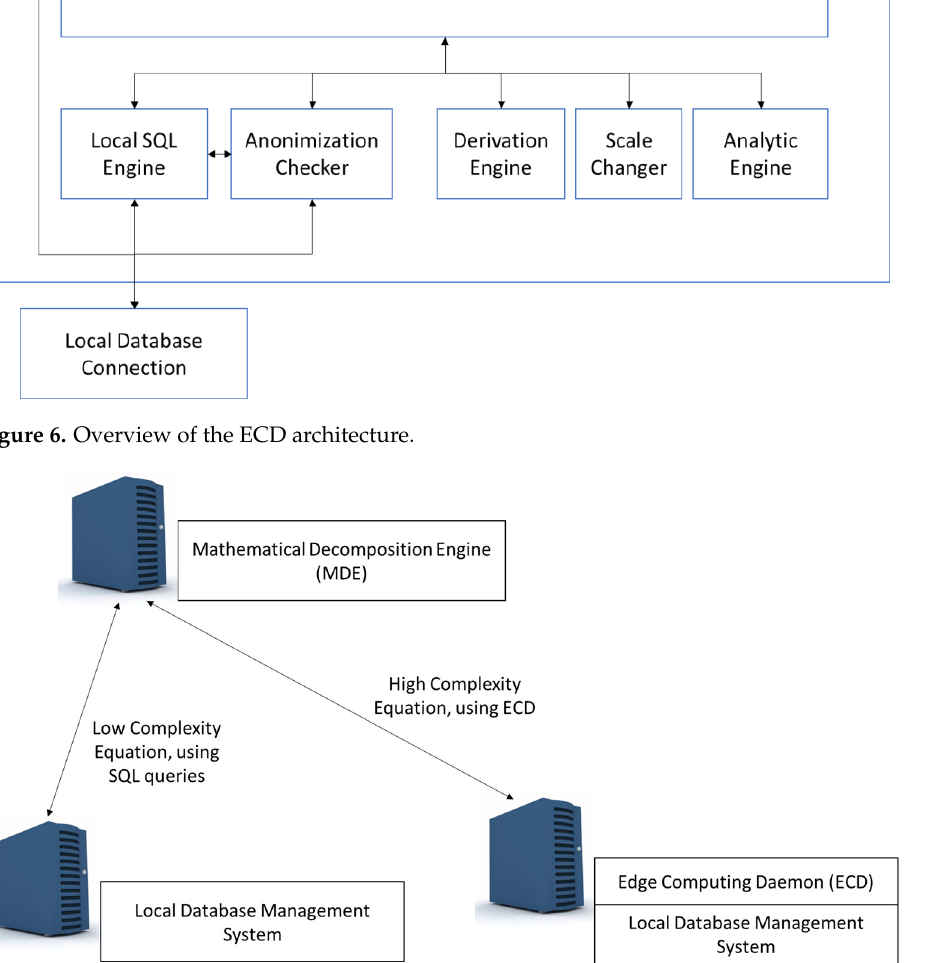
Figure 7. Strategies for distributed data mining.